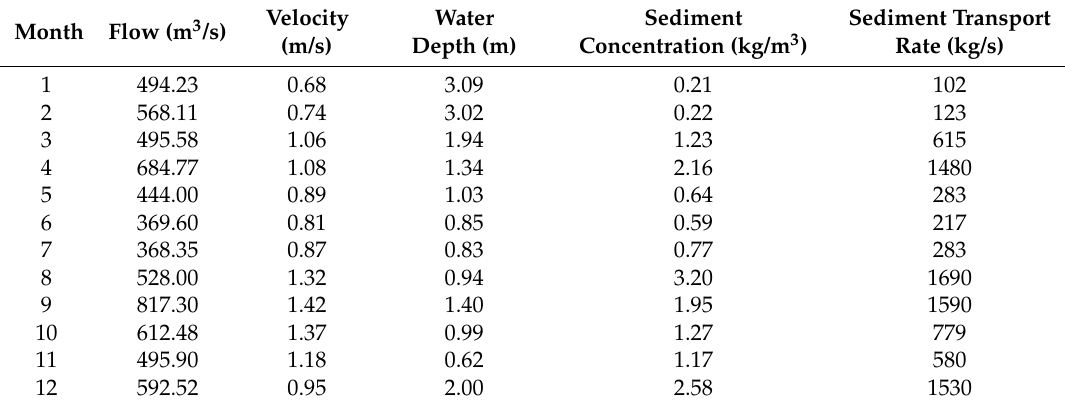
Table 3. Monthly average hydrologic data (2011).